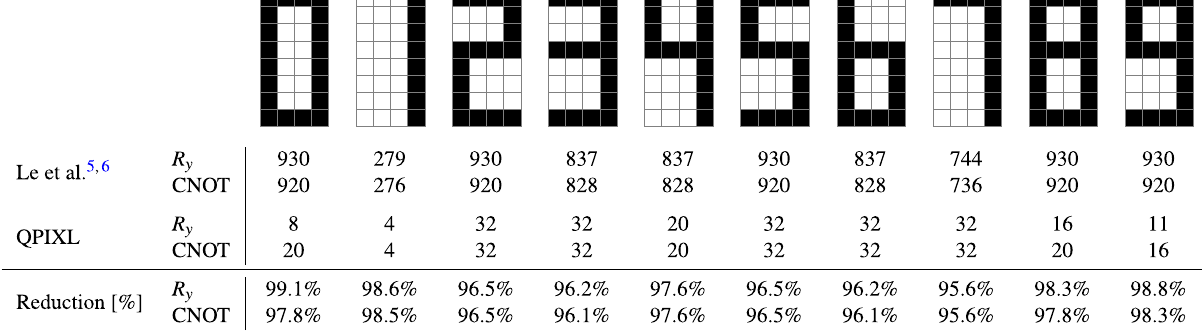
4 image data containing digits 0–9, experiment replicated from Le et al. 6 . Gate complexities for Figure 4. 8 × the 6-qubit U R circuits that prepare an exact representation of the image data. The last two rows provide the reduction in gate count for our method compared to Le et al. 5,6 . All circuits contain 5 Hadamard gates to create an equal superposition over the first register.